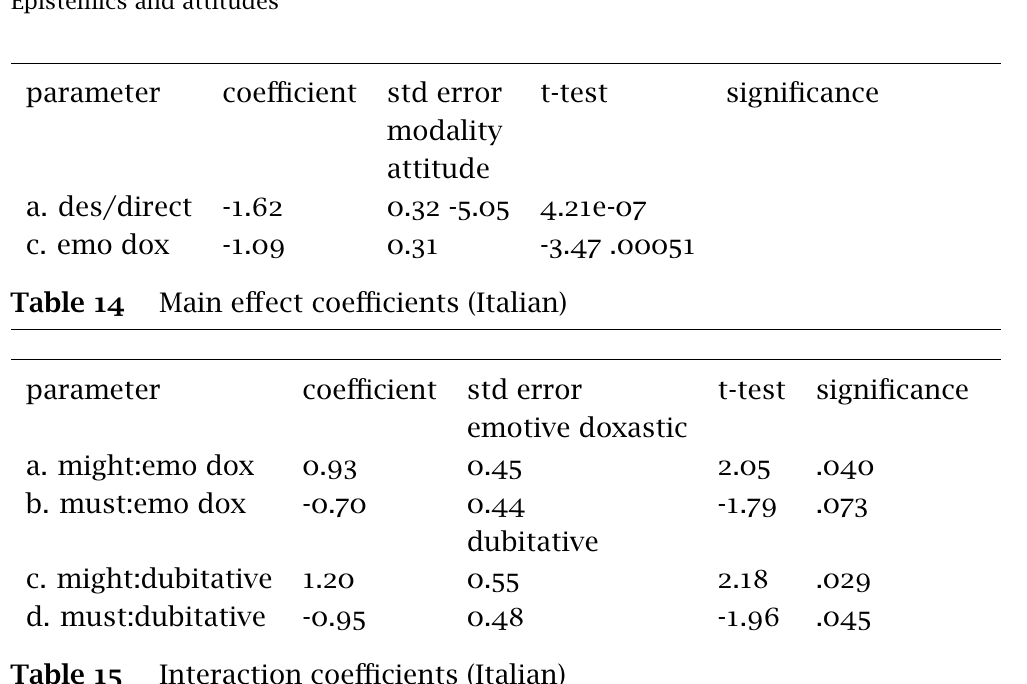
Interaction coefficients